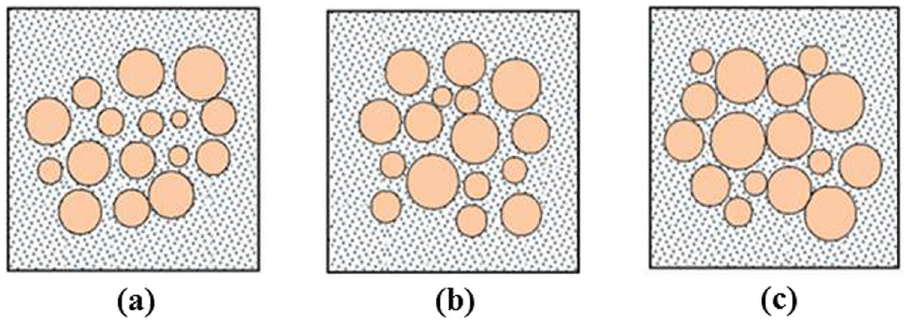
Figure 5: Random arrangements of carbon nano fi bers with a content of 39.13% in nanocomposites. ( a ) case 1; ( b ) case 2; ( c ) case